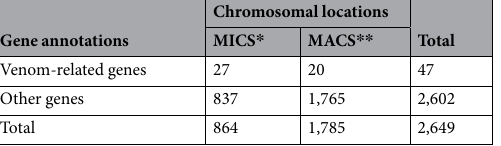
Table 2. Number of genes anchored to MICS and MACS. p = 0.0004 (Fisher’s exact test). * Numbers of genes assigned on microchromosomes. ** Numbers of genes assigned on